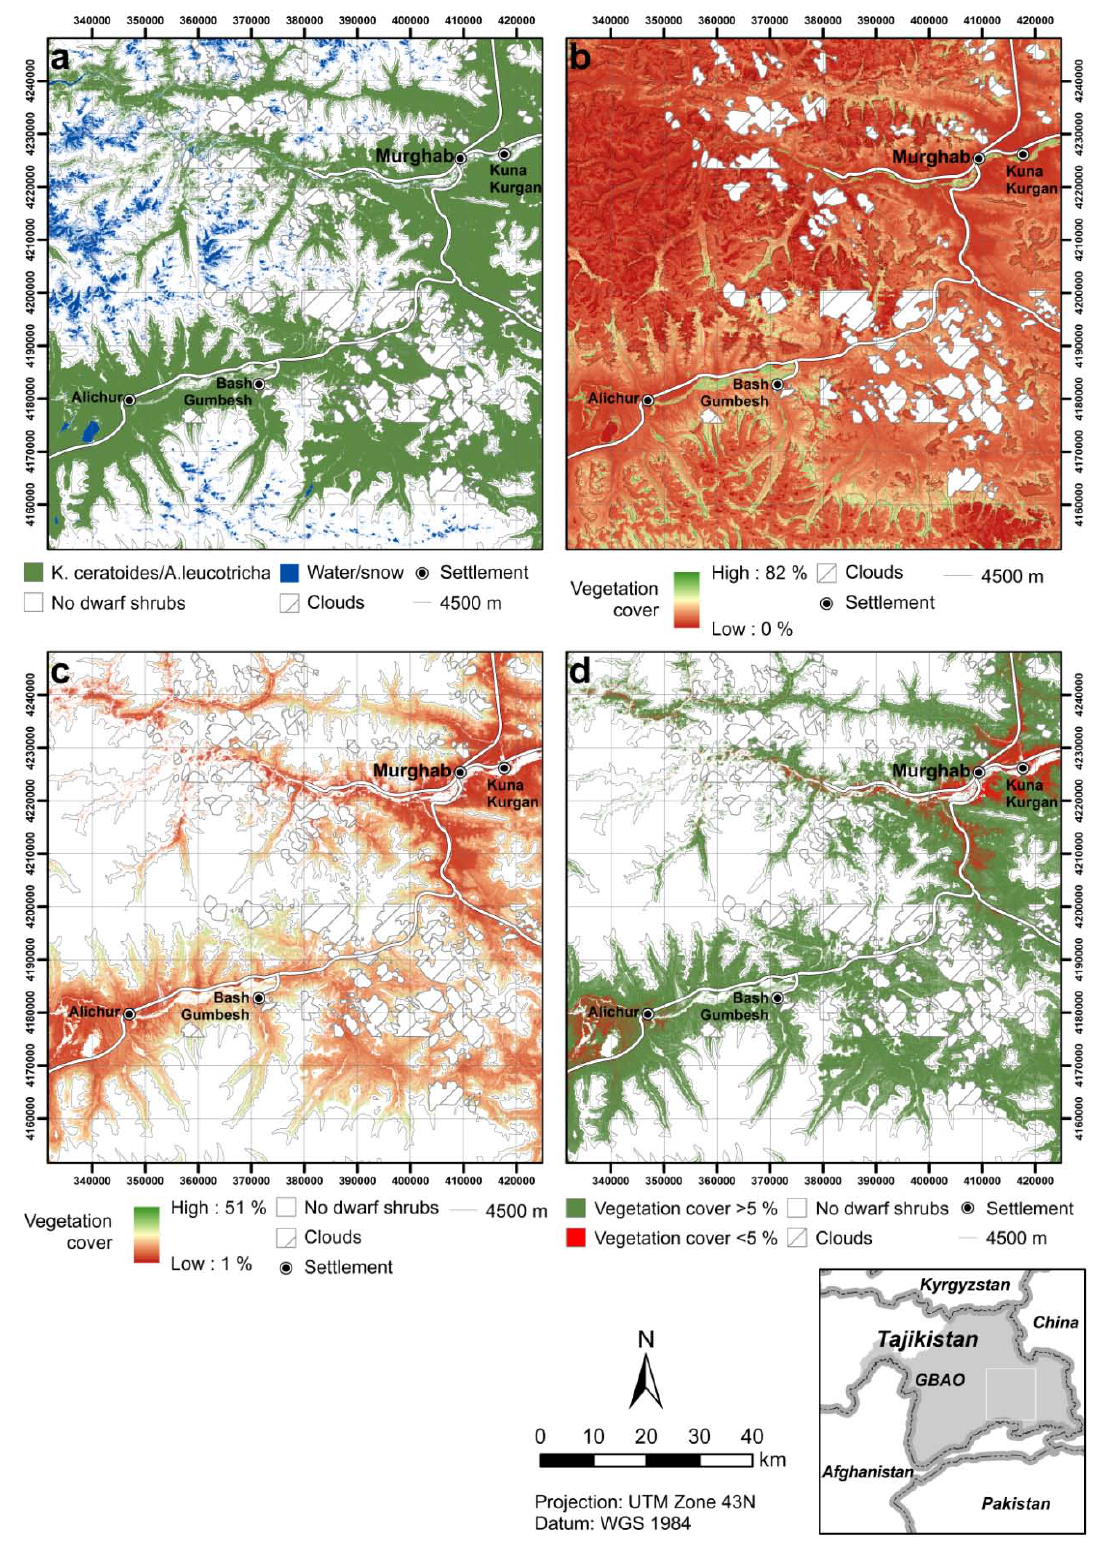
Figure 4. Vegetation map representing ( a ) the presence/absence of A. leucotricha and/or K. ceratoides. ( b ) The total vegetative ground cover. ( c ) The total vegetative ground cover for the area where A. leucotricha and/or K. ceratoides are present. ( d ) The area with less than 5% total vegetative ground cover for the area where A. leucotricha and/or K. ceratoides are